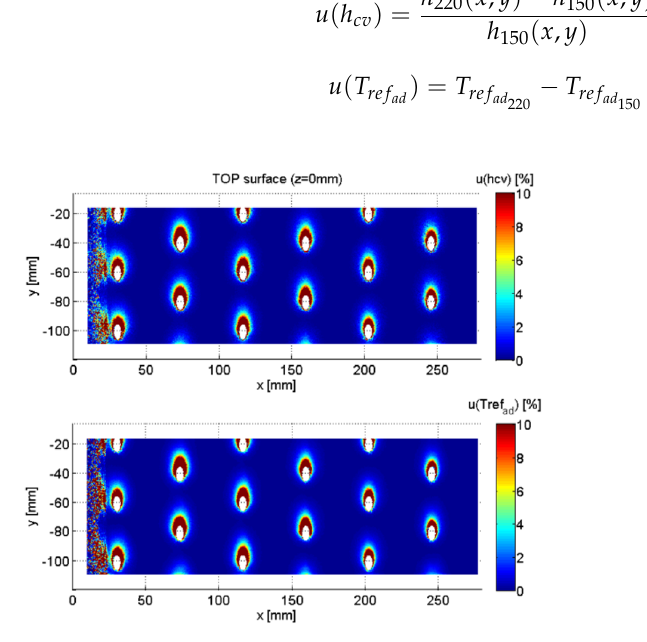
Figure 25. Sensitivity of HTC and adiabatic temperature to HTC in the